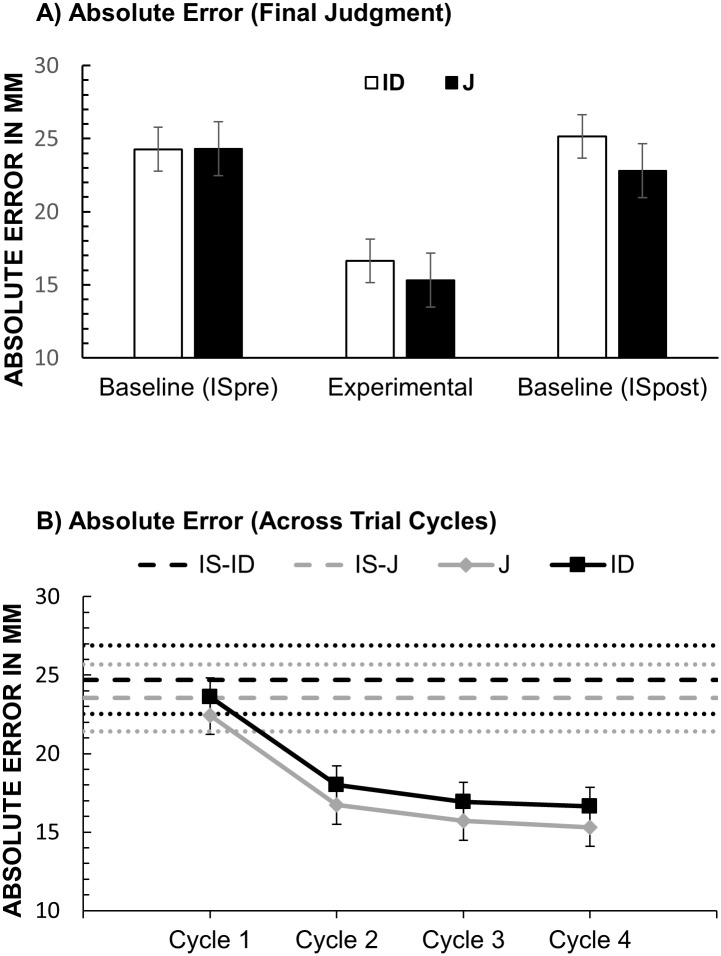
Results of Experiment 1: Absolute error.(A) Absolute error (mm) of final judgments (fourth cycle) in the ID and J condition and in the corresponding ISpre and ISpost baselines. Error bars stand for within-subject 95% CI [39]. (B) Absolute Error across consecutive cycles in the ID and J conditions. For each cycle error from two corresponding turns was averaged (e.g. Cycle 1 is the average of Turn 1 and 2). Error-bars stand for within-subject 95% CIs from the Condition × Cycle ANOVA (see main text). Dotted lines stand for the upper and lower SE of the means from the corresponding IS baseline (dashed lines).